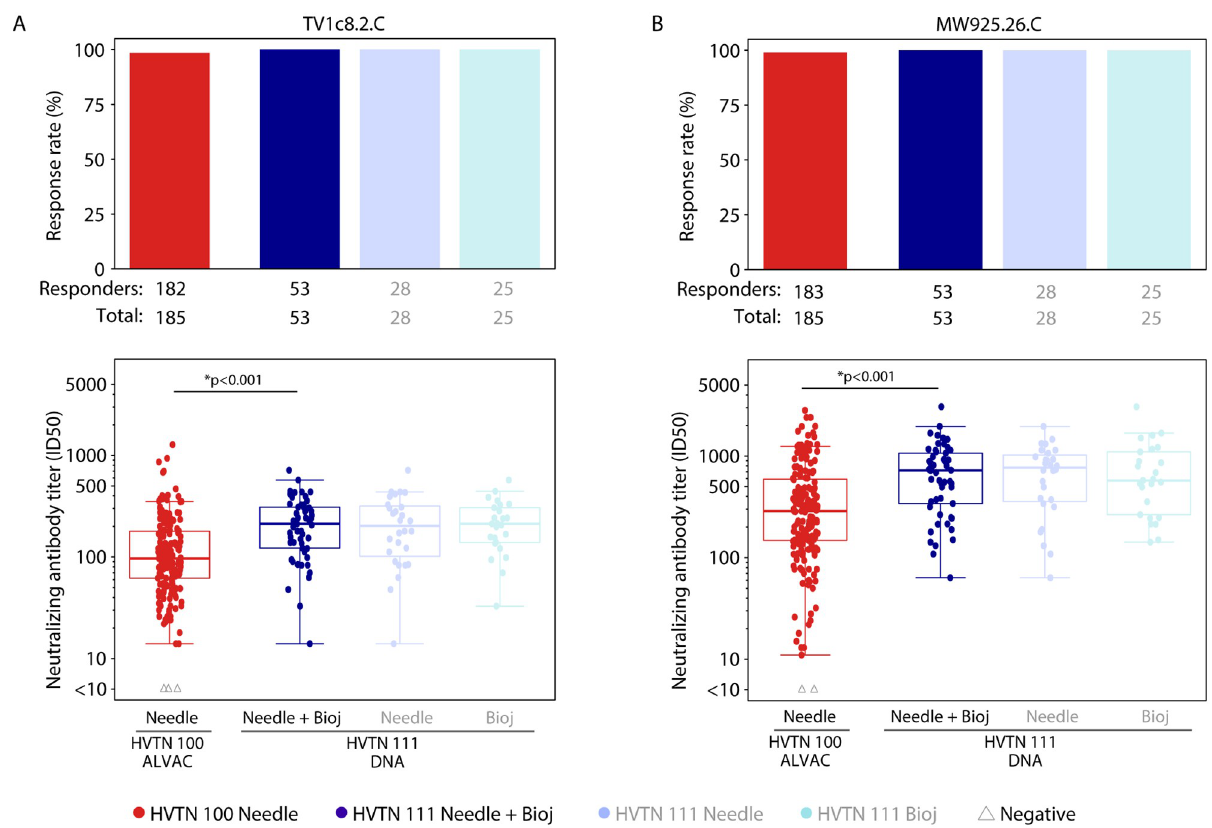
Fig 4. nAb responses to tier 1A Env pseudoviruses among per-protocol vaccine recipients at month 6.5. Bar charts show the observed, unadjusted positive response rates. Boxplots show observed responses and are based on positive responders only (shown as colored circles), negative responders are shown as grey triangles. � TMLE p -values reported; Wilcoxon p -values also < 0.001. HVTN 100 is compared only to the combined arms of HVTN 111 (shown in dark blue) as no differences were seen between the needle and Biojector arms of HVTN 111 (shown in pale blues). env, envelope; HVTN, HIV Vaccine Trials Network; ID50, 50% inhibitory dilution; nAb, neutralizing antibody; TMLE, targeted minimum loss estimation.